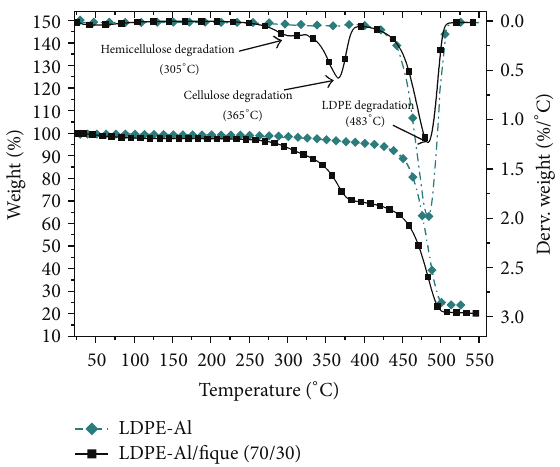
Figure 9: TGA thermogram for LDPE-Al compound and 30% fique fibers compound.